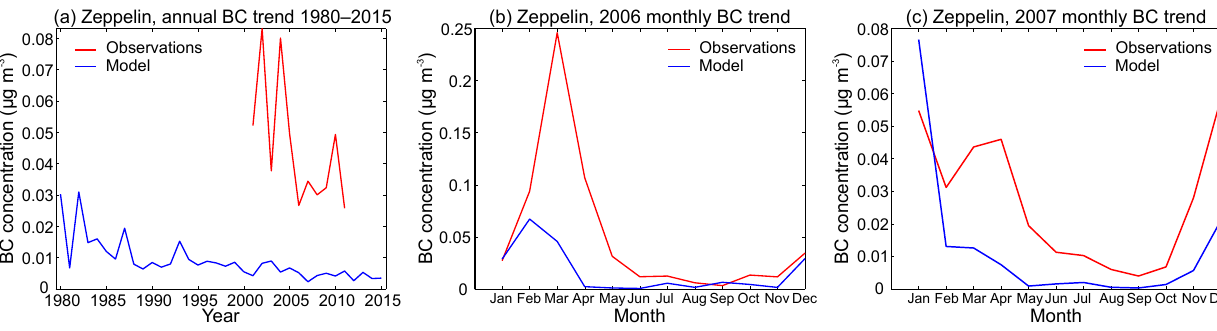
Figure 5. Observed atmospheric BC concentrations compared to modelled atmospheric BC concentrations at Zeppelin monitoring station Ny-Ålesund, Svalbard. (a) Modelled annual average BC concentrations from 1980 to 2015 and observed annual average BC concentrations from 2002 to 2011. (b, c) Comparison of modelled and observed monthly average atmospheric BC concentrations for 2006 (b) and 2007 (c) .